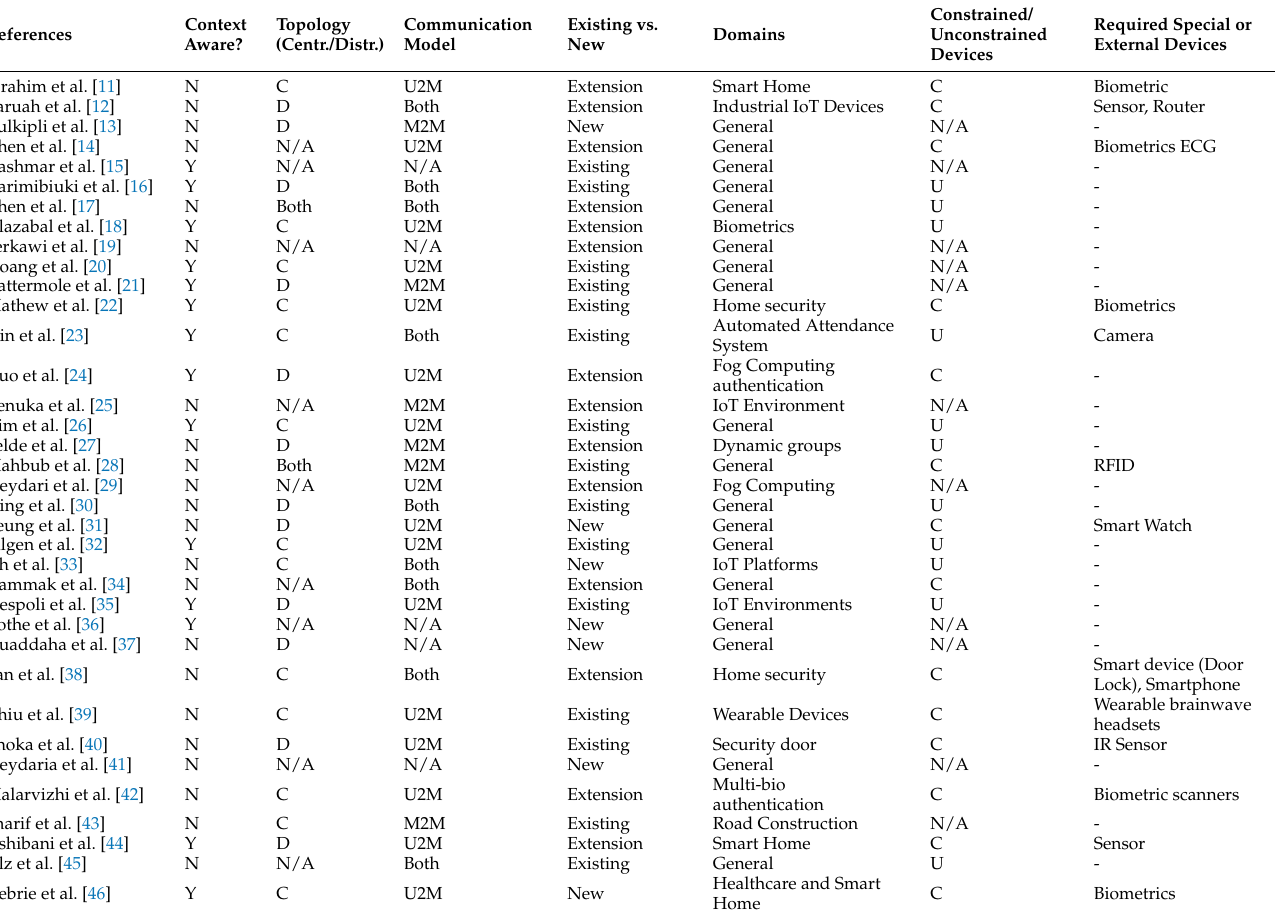
Table 4. Selected paper categorization part